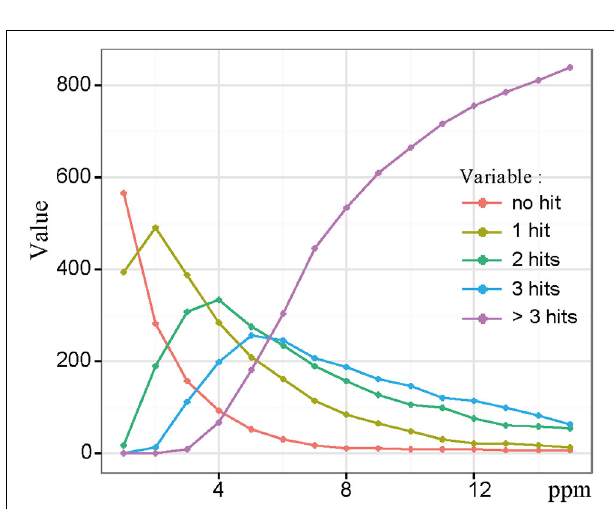
possibly corresponding to detected masses from all of the ( − ) FTICR-mass spectra; (C) Venn diagrams showing the convergence between annotations from different data bases (MassTRIX vs. home build wine data base, top).